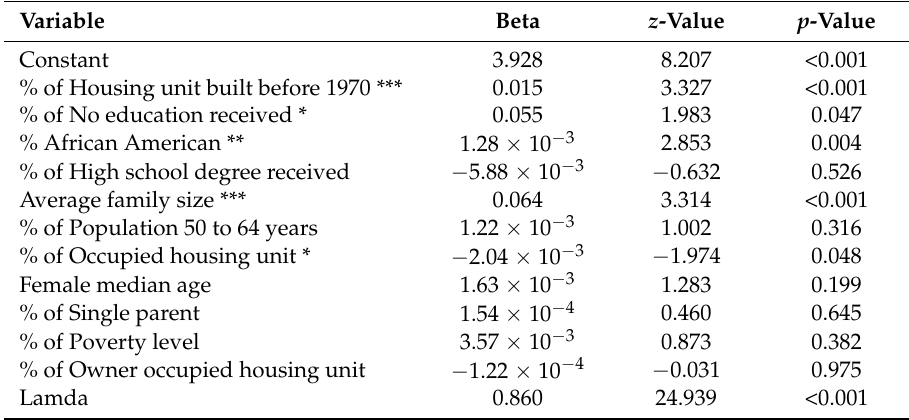
Table 6. Estimated results of regression models of pollution hazard intensity, as a function of socioeconomic profiles; Spatial error